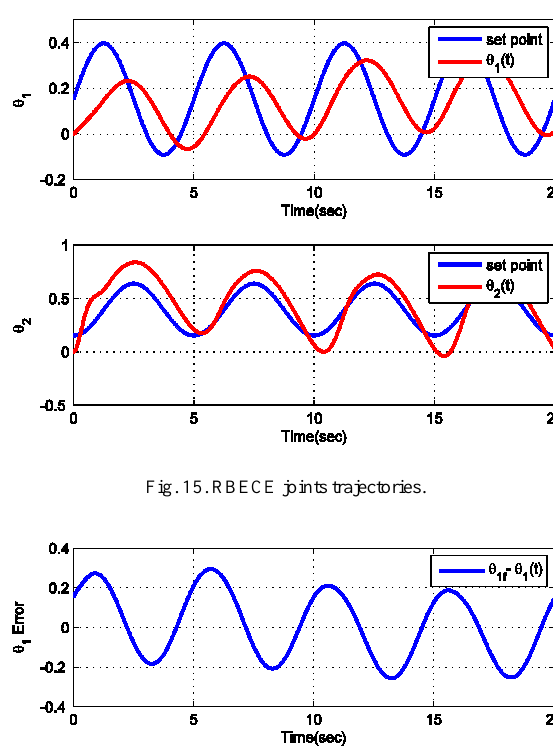
Fig. 11. MAE tracking errors.